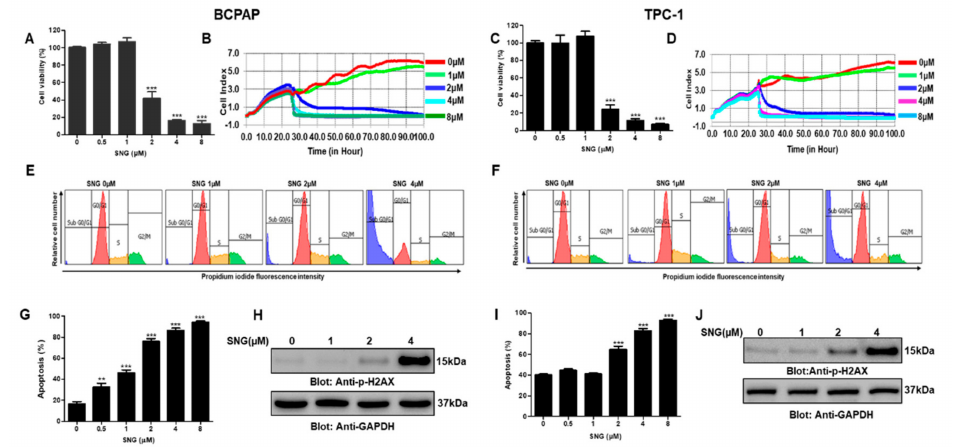
Figure 2. Sanguinarine (SNG)-mediated cytotoxic e ff ects in papillary thyroid cancer (PTC) cells. BCPAP ( A ) and TPC-1 ( C ) cells were treated with 0 µ M, 0.5 µ M, 1 µ M, 2 µ M, 4 µ M and 8 µ M SNG for 24 h. Cell proliferation assay was performed using the CCK-8 kit, as described in materials and methods. Values are expressed as the mean +/ − SD (standard deviation) of at least six replicates ( n = 6) with p value *** p < 0.001. Real-time cell proliferation (cell index) of PTC cells in response to SNG: BCPAP ( B ) and TPC-1 ( D ) cells were seeded on electrodes containing E-Plate VIEW 16 (ACEA Biosciences, Inc.) and after 24 h, treated with di ff erent doses of SNG, as indicated, followed by monitoring of cell growth in real-time as described in materials and methods. SNG induced cell cycle arrest in PTC cells: BCPAP ( E ) and TPC-1 ( F ) cells were treated with indicated doses of SNG for 24 h and analyzed by flow cytometry to detect cell cycle fractions, as described in materials and methods. SNG-mediated induction of apoptosis in PTC cells: BCPAP ( G ) and TPC-1 ( I ) cells were treated with SNG, as